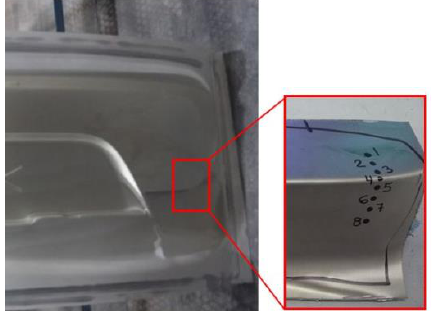
Figure 5. The deformed part and the 8 measuring points on the critical region.